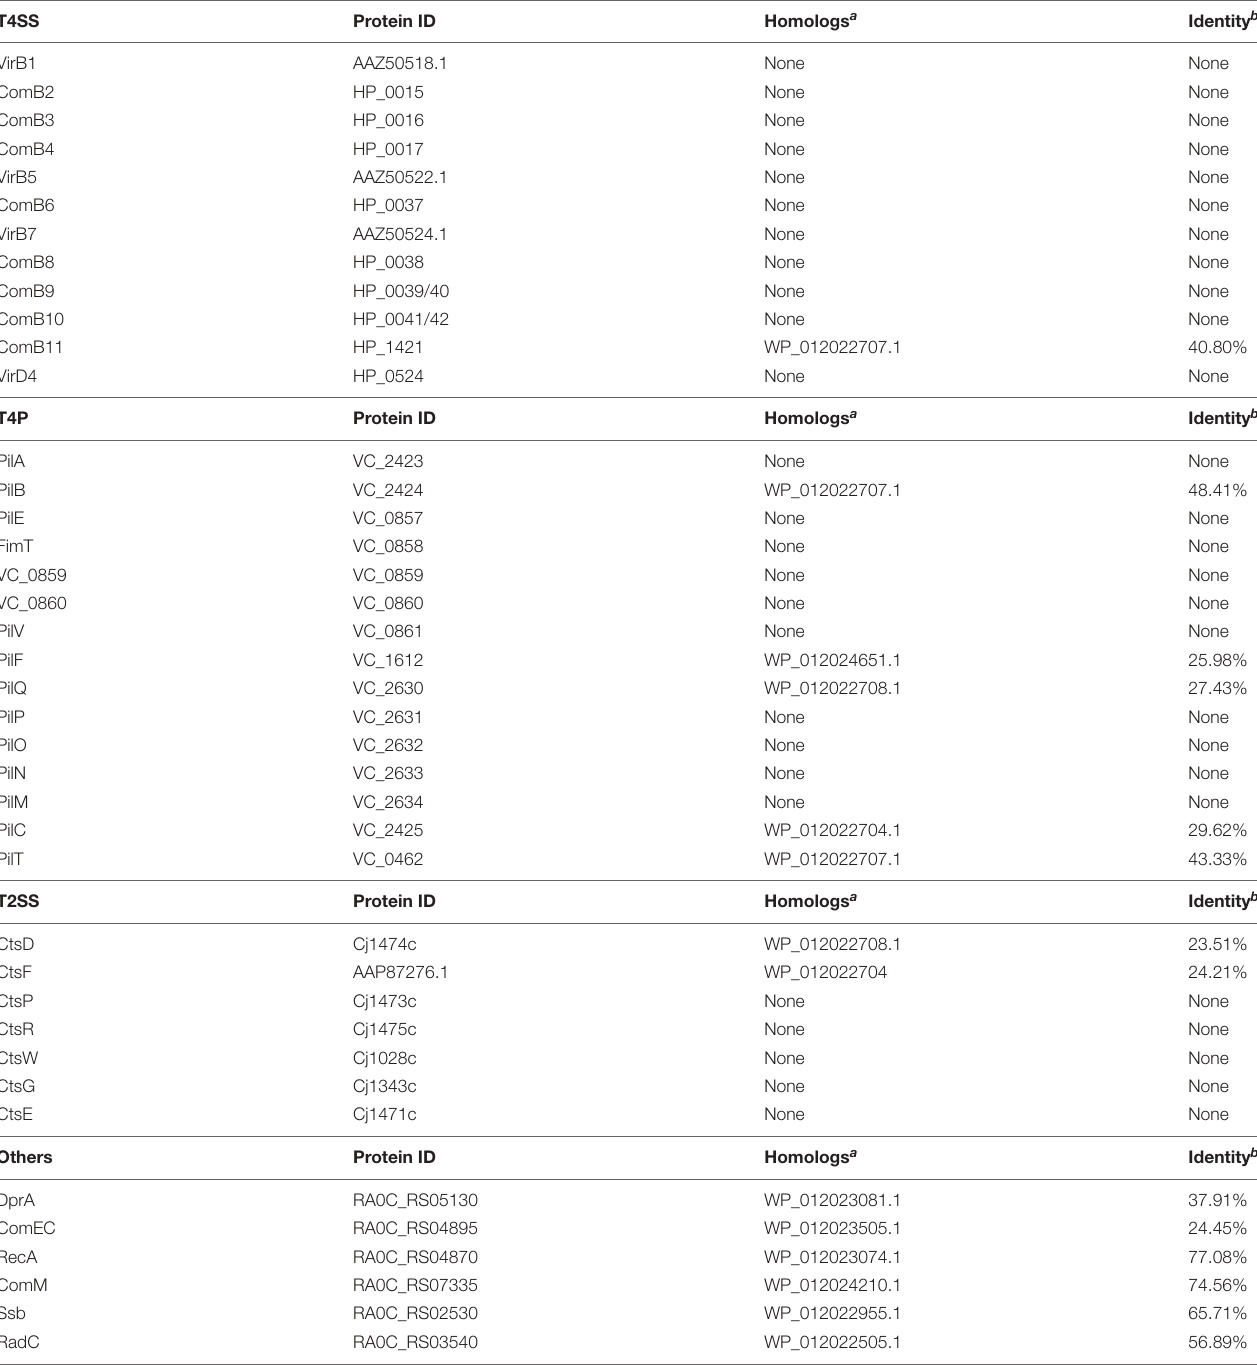
TABLE 2 | Homologs of T4SS, T4P, T2SS, and other competence proteins in F.